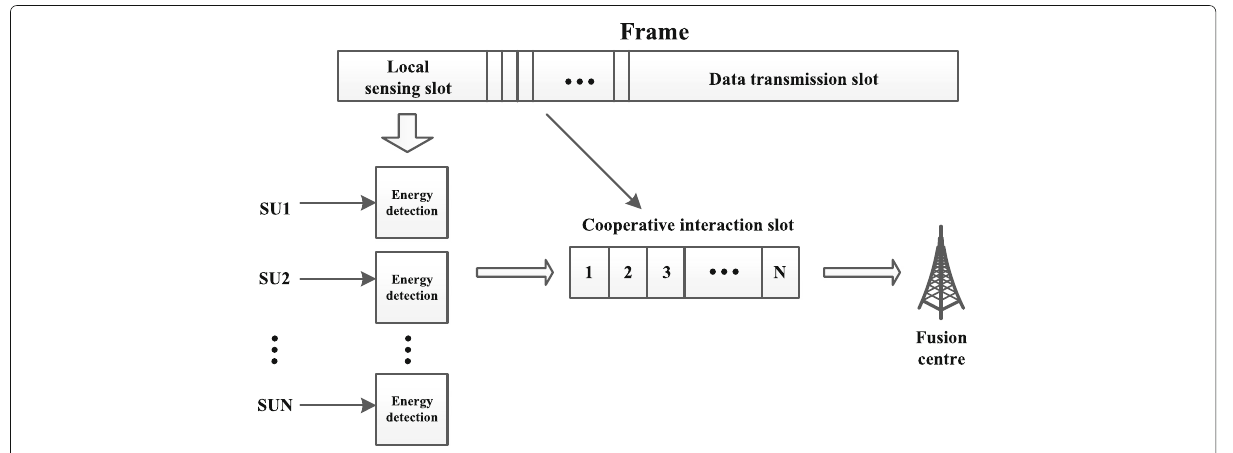
Fig. 1 Periodic cooperative spectrum sensing